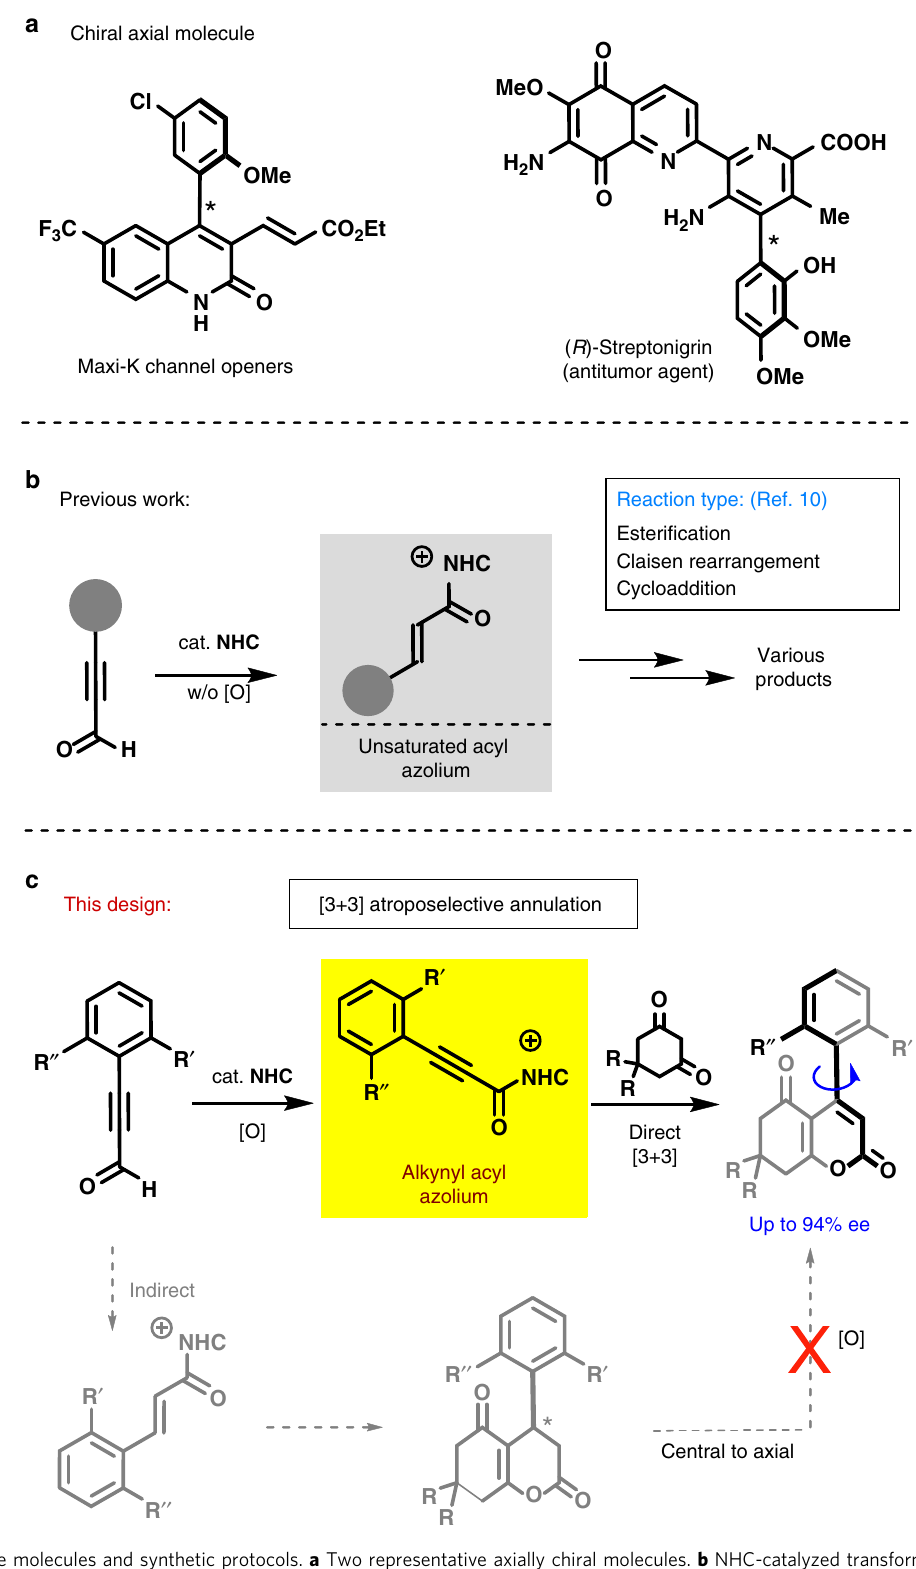
Fig. 1 Representative molecules and synthetic protocols. a Two representative axially chiral molecules. b NHC-catalyzed transformations via the use of unsaturated acyl azolium intermediate. c Our synthetic proposal via [3+3] atroposelective annulation. NHCs react with ynals to generate chiral alkynyl acyl azolium intermediates to further react with cyclic